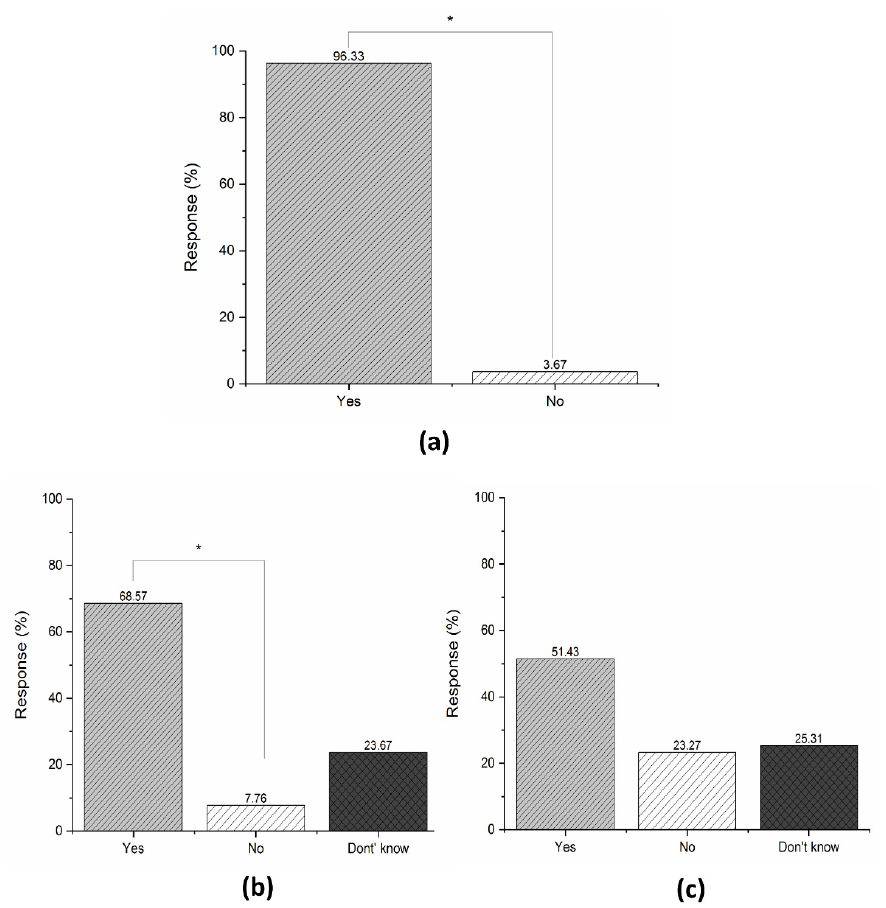
Figure 7. Perception of professionals as evaluated using the following survey questions: ( a ) Did you know that the chamber was developed to reduce the microbial load, including that of the new coronavirus (severe acute respiratory syndrome coronavirus 2 [SARS-CoV-2]), from the surface of personal protective equipment (PPE)? ( b ) Do you consider the use of the disinfection chamber before the PPE doffing process to be a safe option? ( c ) Did you notice if after using the chamber, all surfaces of the personal protective equipment (PPE) were uniformly humidified? * represents p < 0.05 by Friedman test with Dunn’s multiple comparisons test.